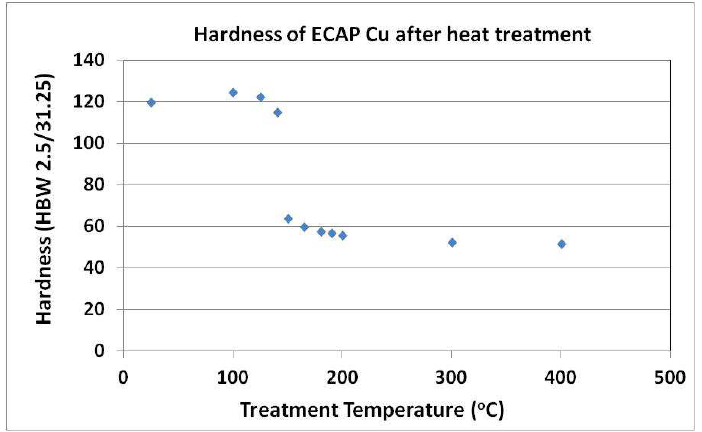
Fig. 4. Evolution of the hardness versus the thermal treatment applied on ECAP